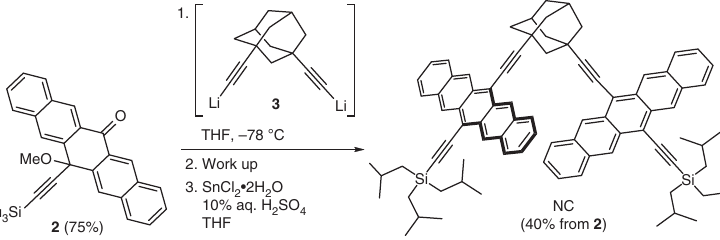
Figure 2 | Synthesis of NC. Detailed steps for the preparation of NC.